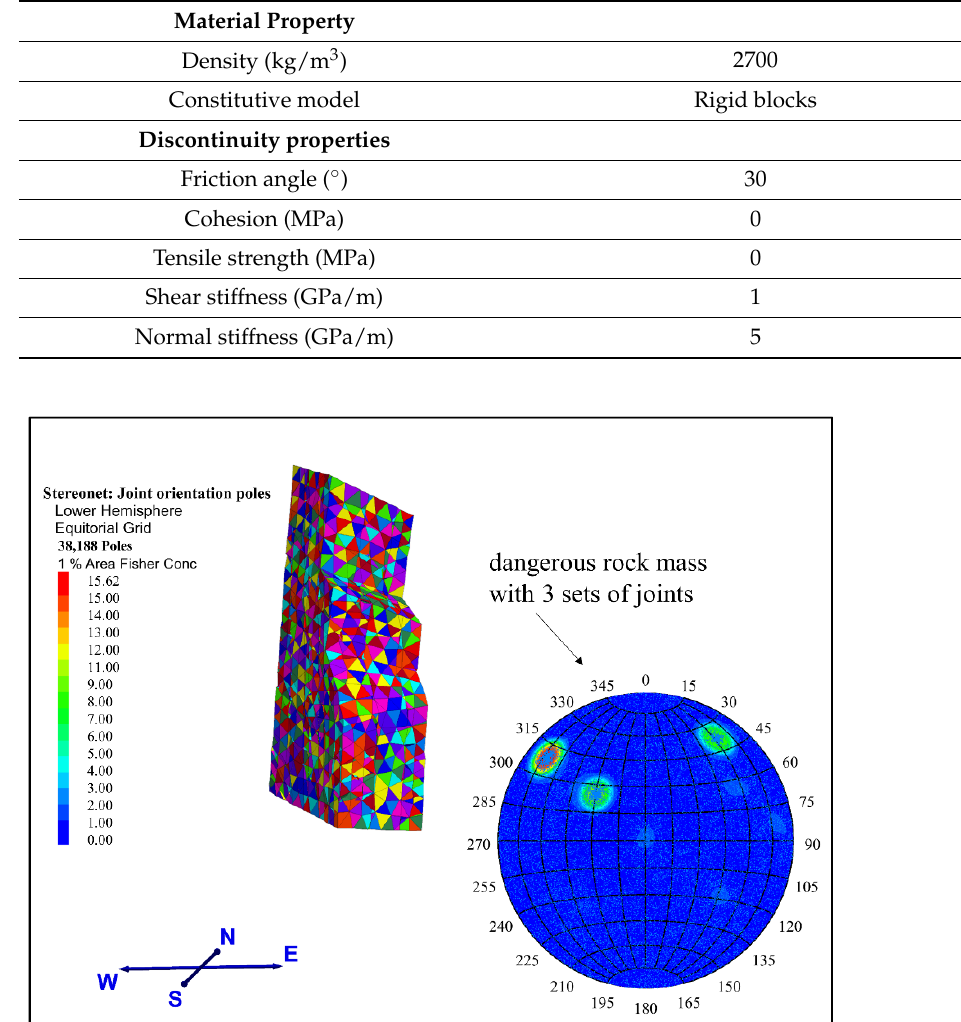
Figure 12. Stereonet of joint sets generated in the three-dimensional distinct element model. Table 5. Physical and mechanical properties used in the 3DEC